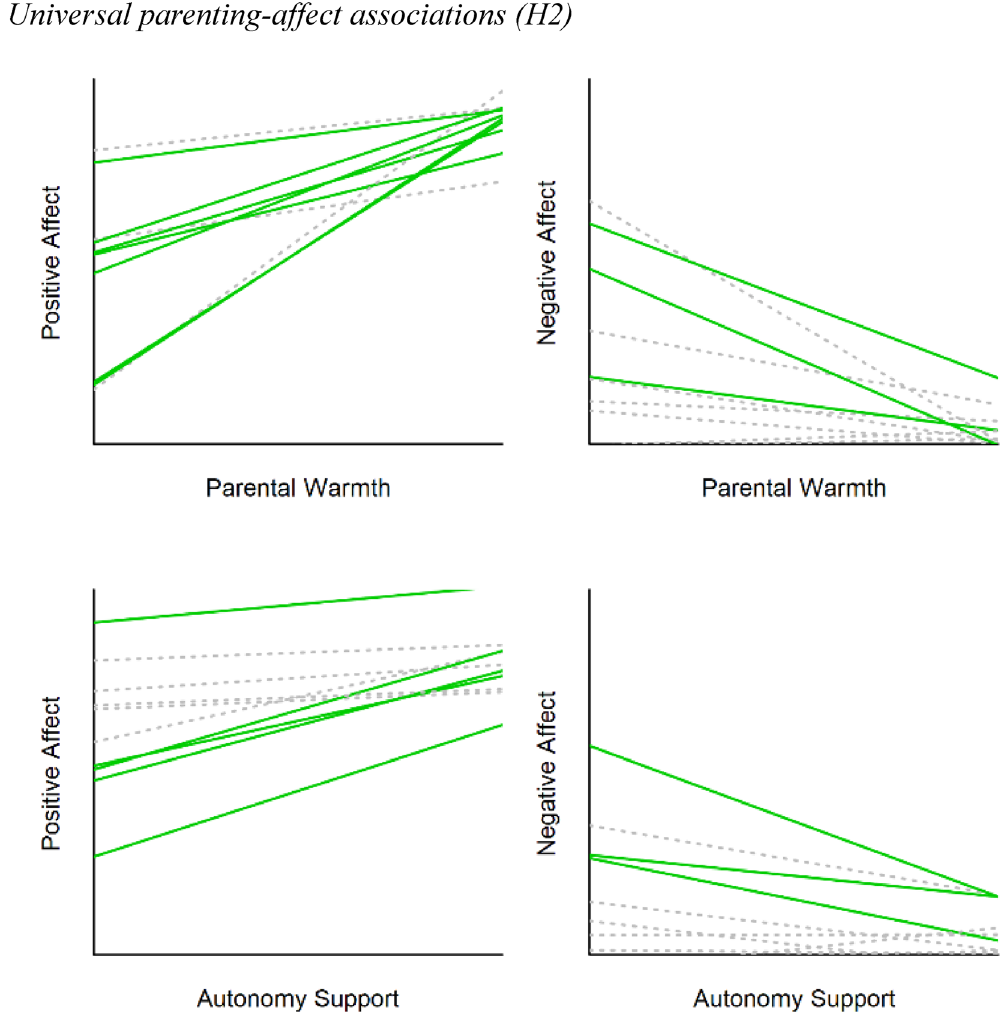
Figure 3. Note: Each line represents the association between parenting and well-being for one family. Ten exemplary families are depicted per model. Green solid lines indicate a significant association in the expected direction (‘correctly classified’) and grey dotted lines indicate a non-significant association (‘ambiguously